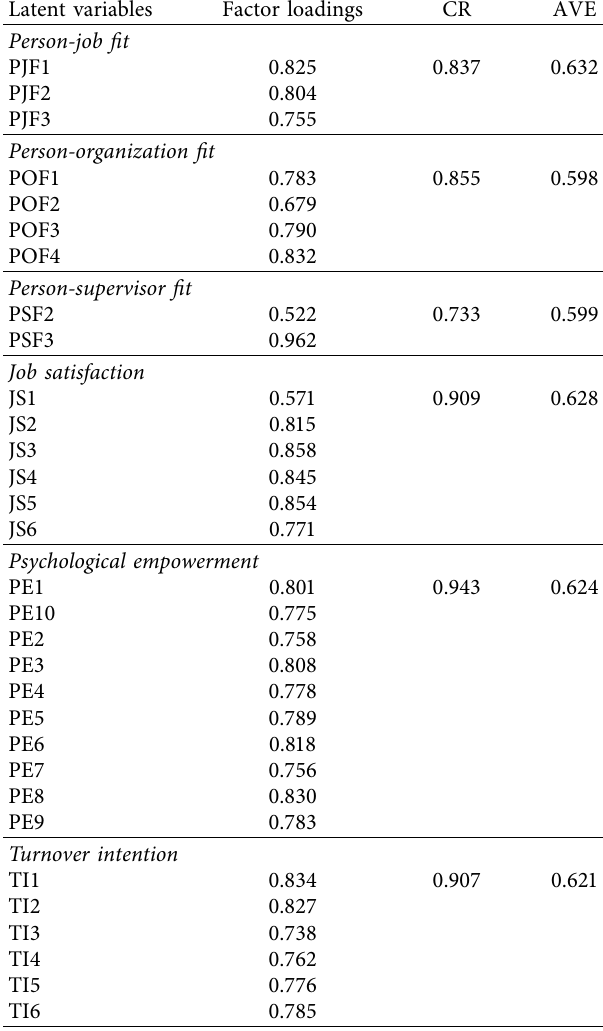
Table 2: Demographic profiles of the participants ( N � 349). Characteristics